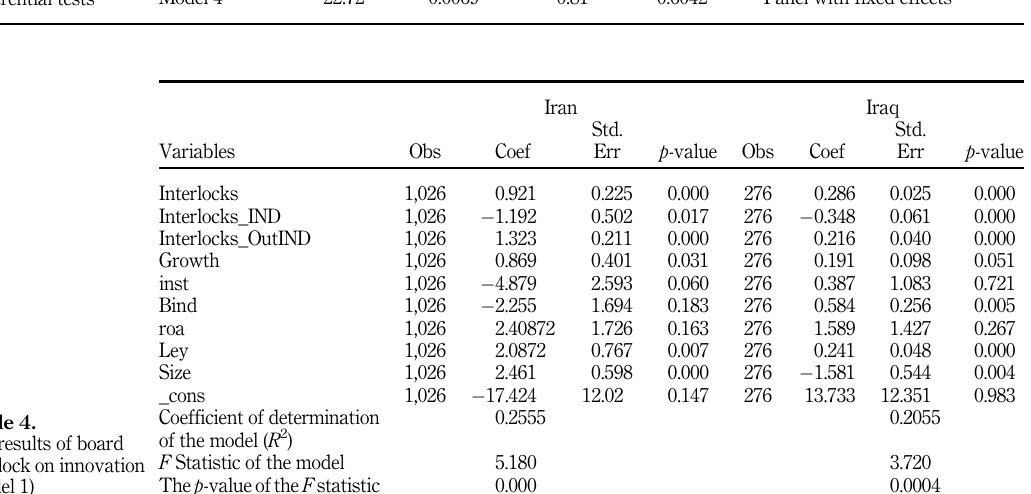
Table 3. The results of the statistical method preferential tests